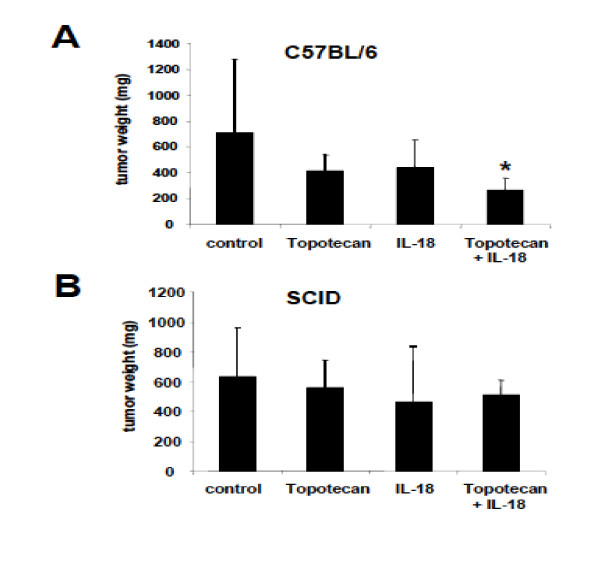
The antitumor effect of combination IL-18/chemotherapy is T cell dependent. C57BL/6 (A) or C57SCID (B) mice were injected s.c. in the flank with ID8-Vegf cells and subsequently treated as described in "Materials and Methods." Mice with no treatment, topotecan alone, IL-18 alone or their combination were sacrificed when control tumors reached a size of approximately 600 to 800 mm3 ; all tumors were excised and weighed. Results are medians ± SEM: interquartile range (25%-75%; n = 10). The asterisk indicates the statistically significant difference between experimental and control groups. In the C57BL/6 mice, the topotecan/IL-18 combination treatment significantly restricted the tumor weight relative to the control group (Student's test, p < 0.05), while independent monotherapies did not. In the SCID mice the effect of the combinatorial therapy on the tumor growth was lost with no significant differences between the groups.